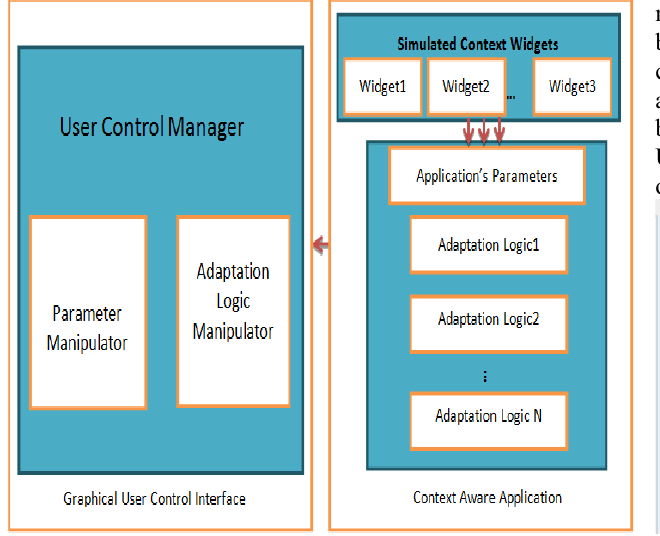
Figure 1. High Level System Architecture